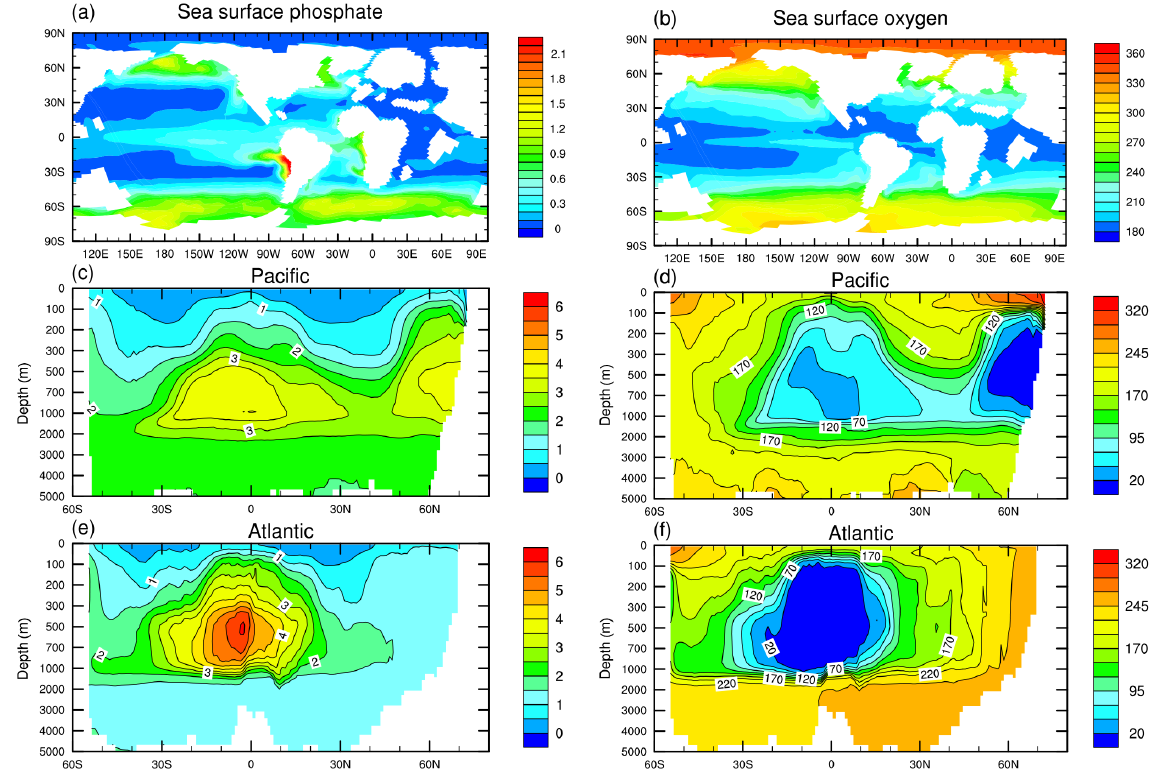
Figure 7. Phosphate (left) and oxygen (right) concentrations (both in µmolL − 1 ) for the surface (a, b) , Pacific (c, d) , and Atlantic (e, f) averaged meridional crosscut. Note the nonlinear vertical axes, used to zoom in on the upper ocean